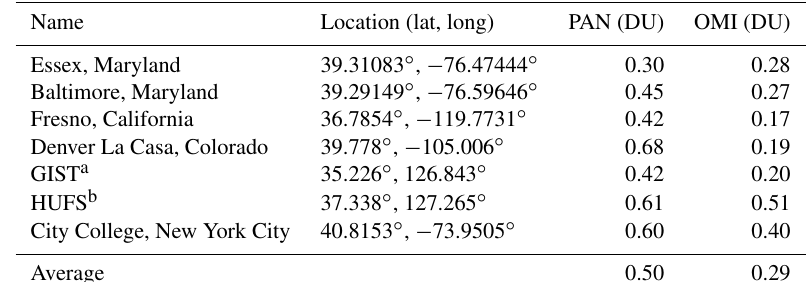
Table 2. Average values of TCNO 2 for PANDORA and OMI for additional sites.